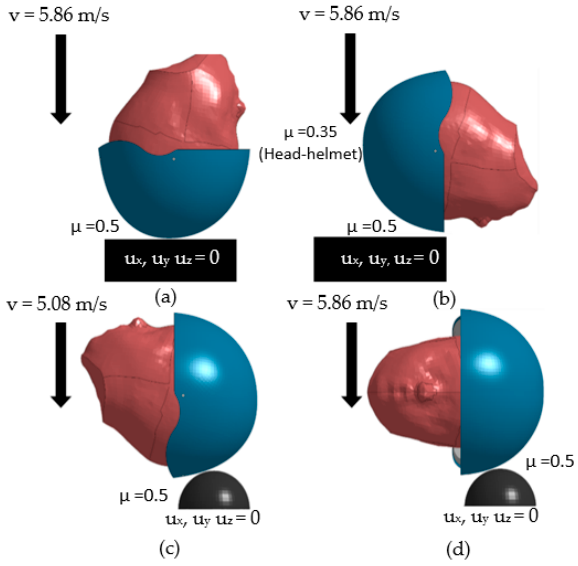
Figure 3. Model setup for the DOT drop test at ( a ) crown, ( b ) front, ( c ) rear, and ( d ) side locations.